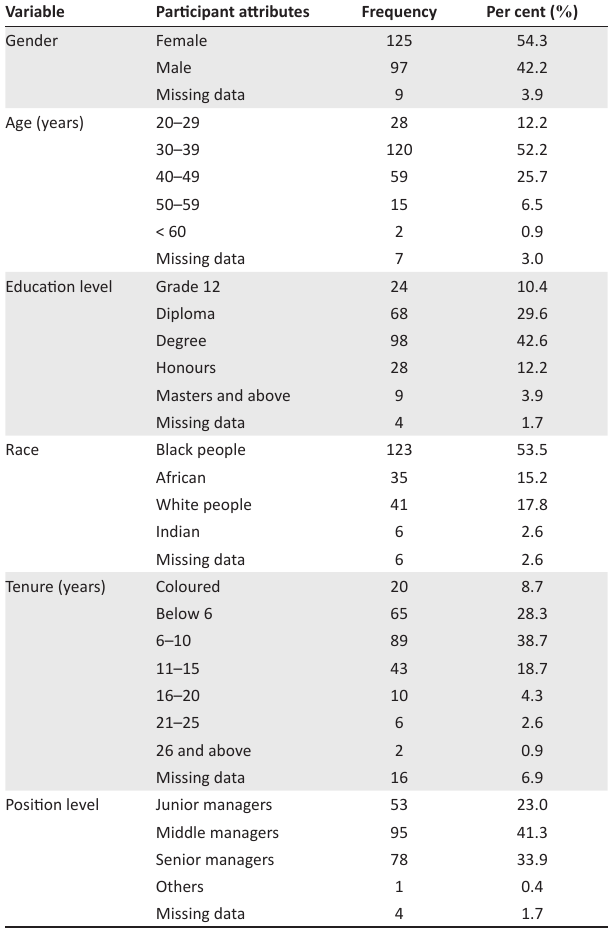
TABLE 1 : Demographic attributes of bank managers respondents ( n = 230).